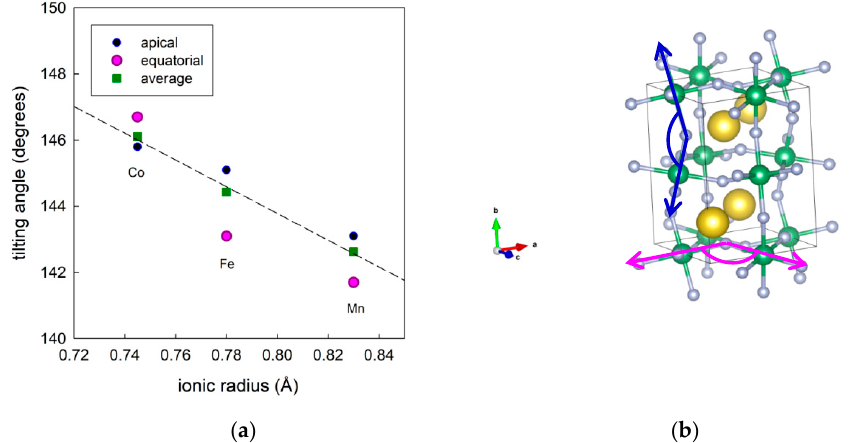
Figure 6. ( a ) F − M − F tilting angle vs. ionic radius for the three end-members NaCoF 3 , NaFeF 3 , and NaMnF 3 . Lines are linearly fit to the data, and error bars are within the size of the symbol; ( b ) schematic representation of the apical (blue) and equatorial (purple) tilting angles. Legend: Na is indicated in yellow; M is indicated in green; F is indicated in